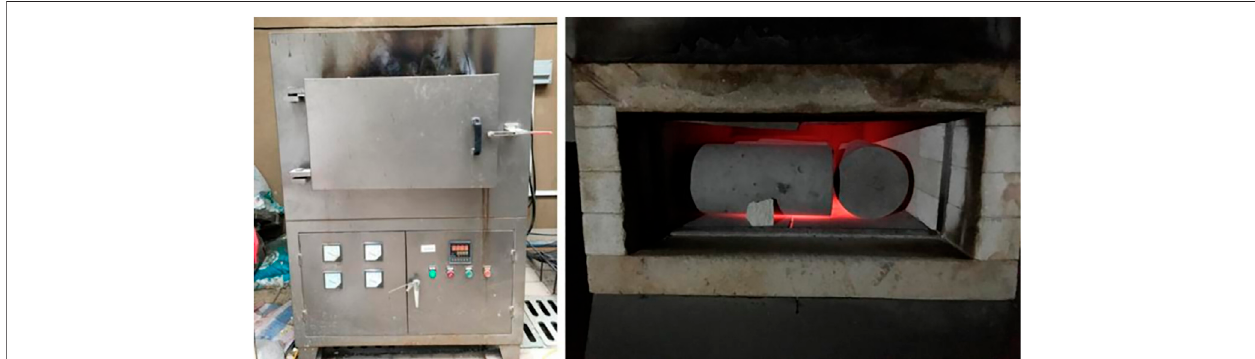
FIGURE 2 | Photograph of the box type electric furnace.